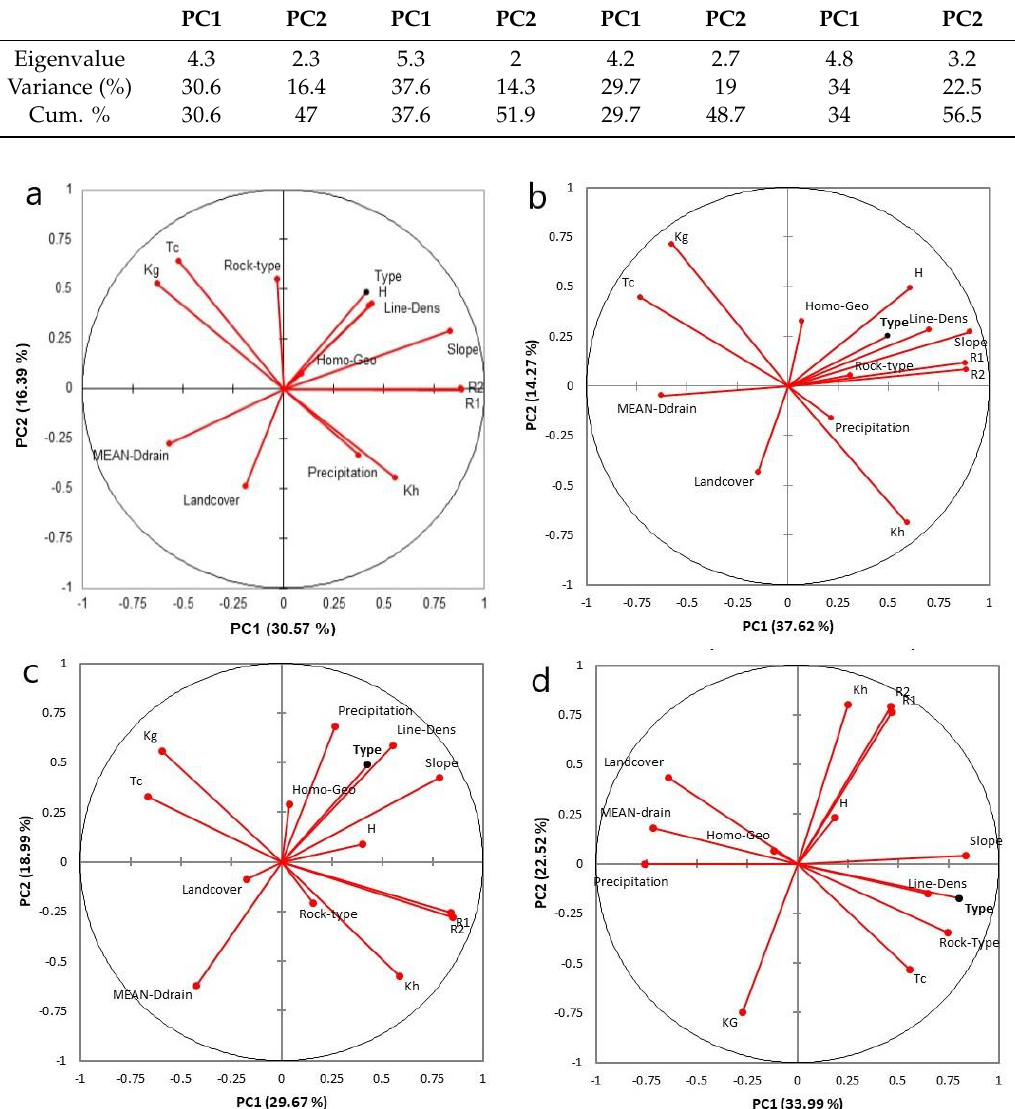
Figure 7. Distribution of the parameters on the first factorial plan (PC1–PC2), for ( a ) the total database, ( b ) the External Rif, ( c ) the Middle Atlas, and ( d ) the Central Anti-Atlas.